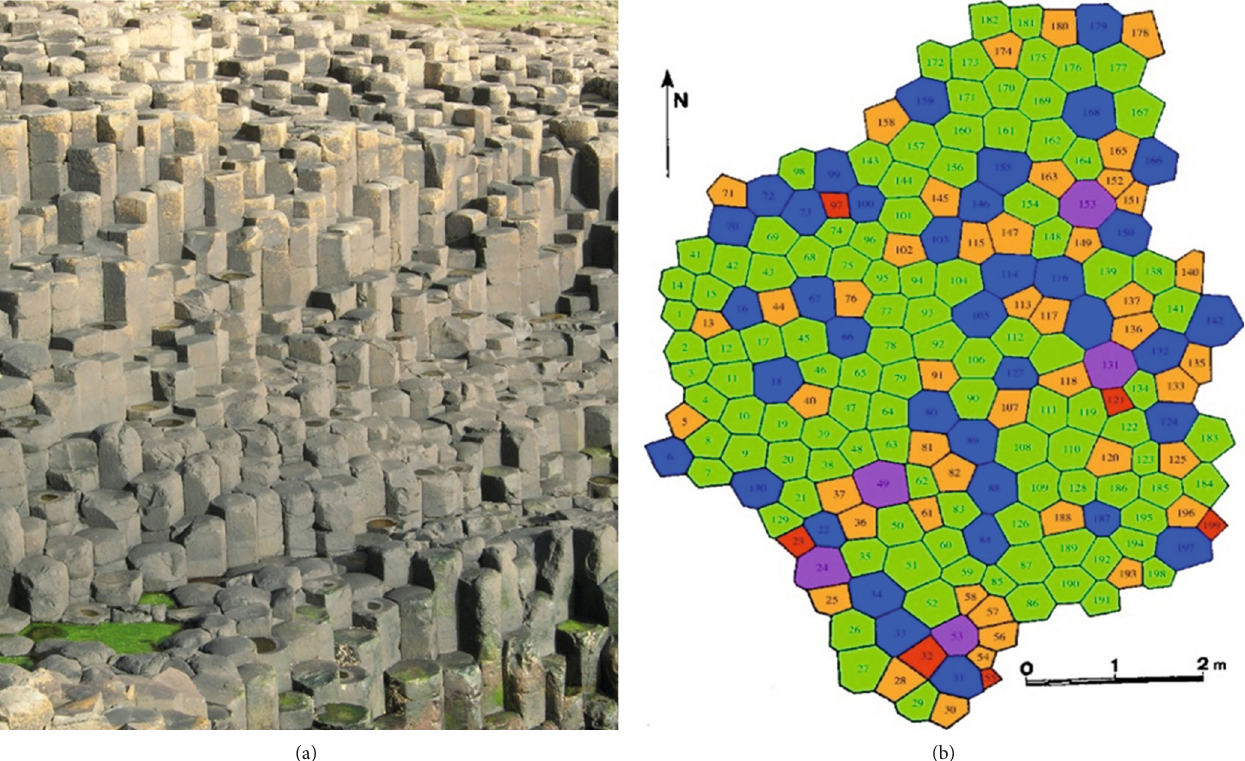
Figure 1: Typical columnar jointed rock masses: (a) Giant ’ s Causeway, Antrim in Northern Ireland and (b) colorized map of about 200 columns